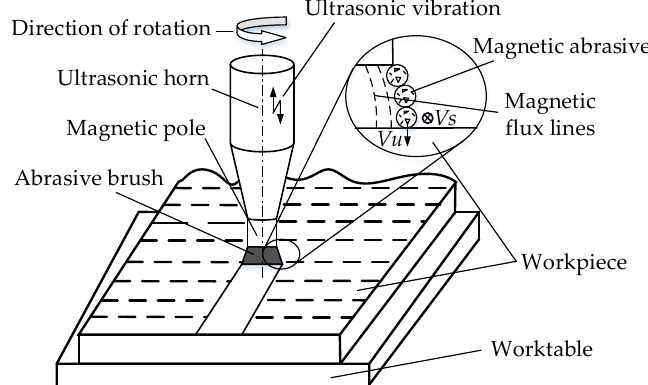
Figure 1. Machining principle of UAMAF.